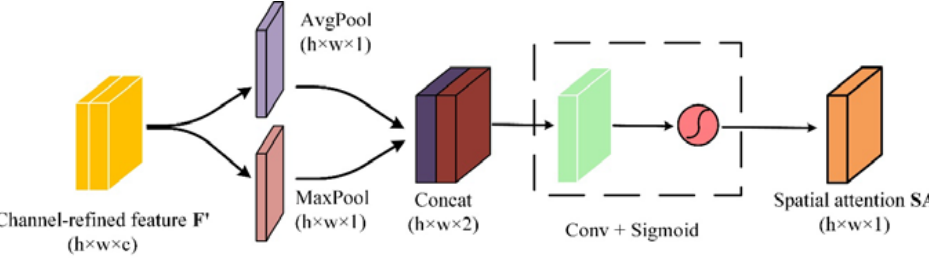
Figure 7. The spatial convolutional attention module.